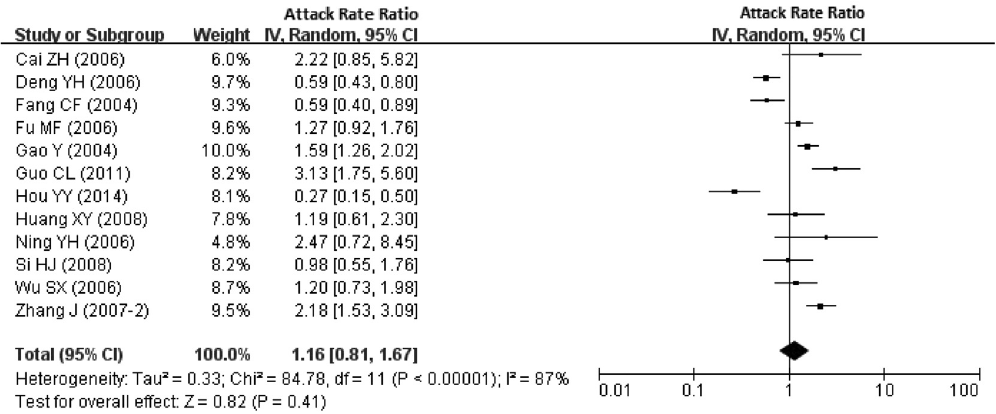
Fig. 6. Forest plot of junior:senior attack rate ratio. Attack rate: the number of new cases divided by the number of persons at risk during the whole